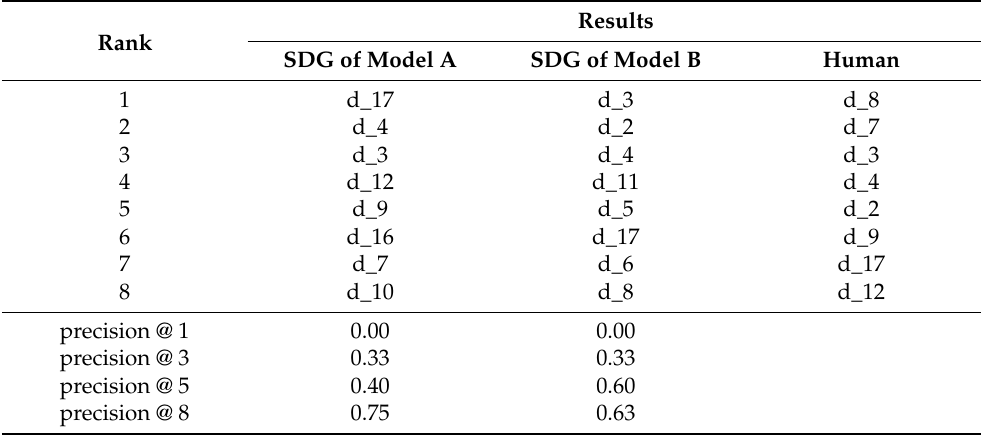
Table 3. Ranking results of Model A and Model B as well as human evaluation for high cognitive diversity case.